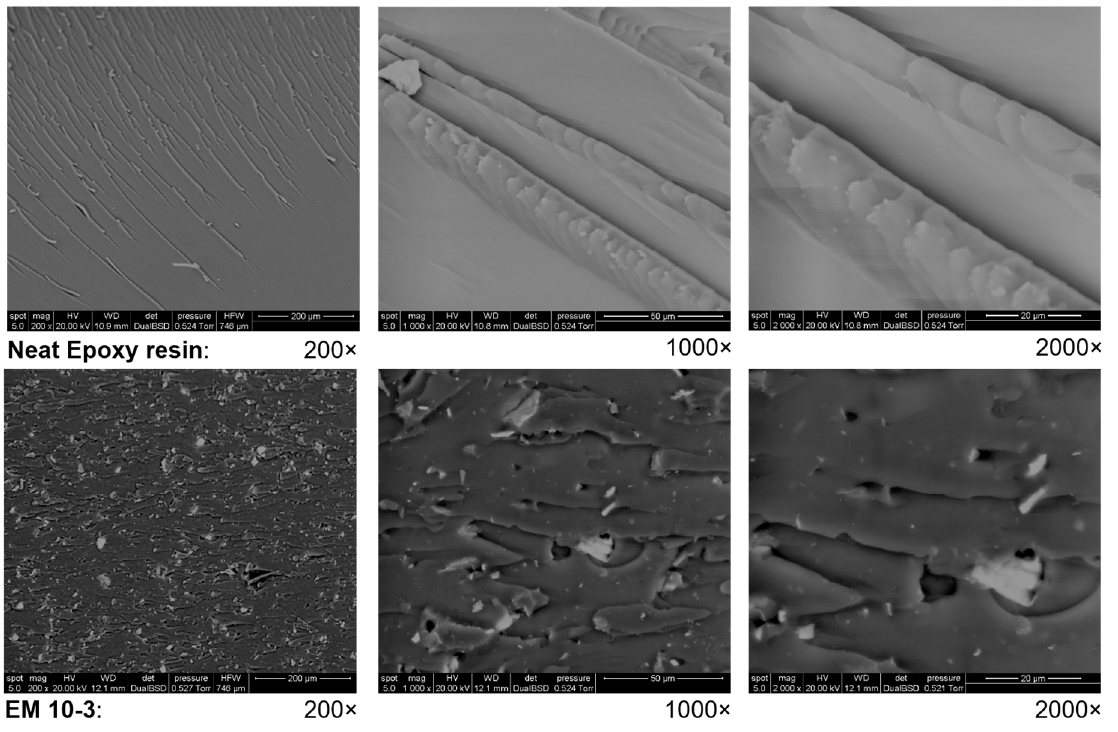
Figure 3. Representative ESEM images of the brittle fracture of the samples of the neat epoxy resin and composite EM10-3 at different magnifications.